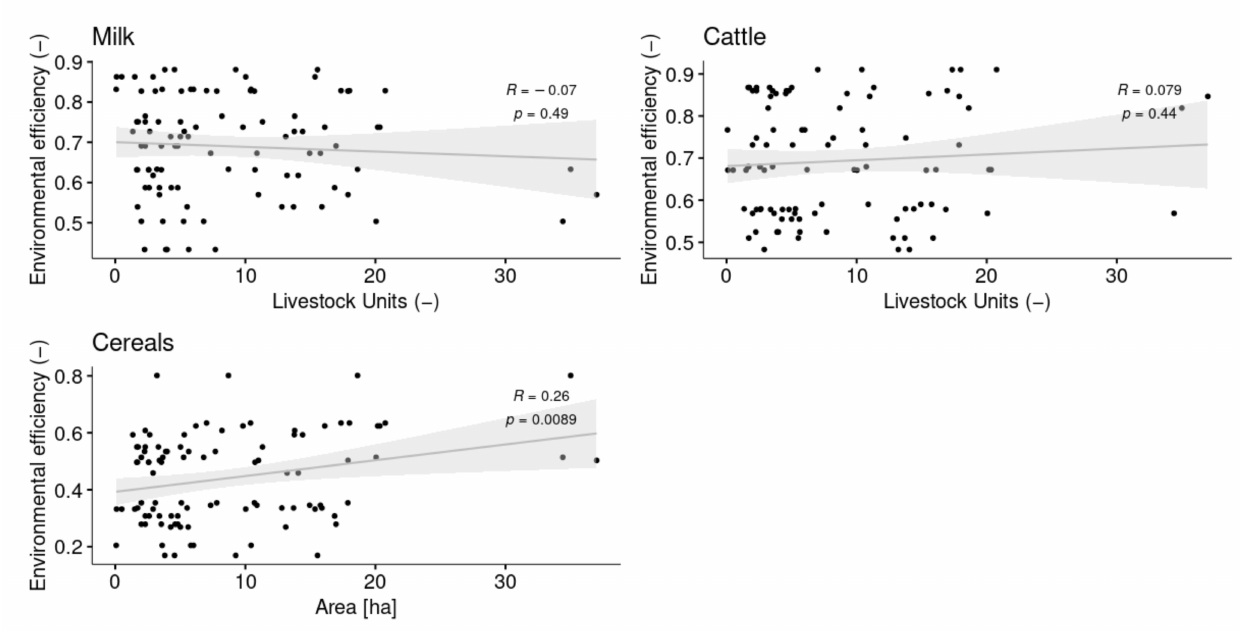
Figure A11. Environmental efficiency for farms with multiple product groups (mixed farms). Farms, where multiple product groups are larger than 33% of the average product group size (see Appendix A), were considered as ‘mixed’ or ‘specialized’ farms. Shown are only farms, which have the three product groups “Milk”, “Cattle breeding”, “Cereals” simultaneously (N = 20). The x -axis shows the size of the product group in Livestock units for animal product groups and hectares for crops. The grey area around the regression line marks the 95% confidence interval. Additionally, the regression coefficient (R) and its p -value ( p ) are shown.